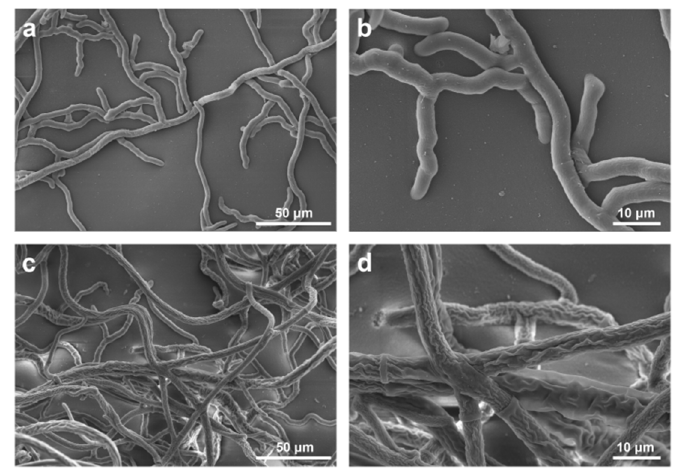
Figure 5. SEM of R. solani hyphae treated with 0 ( a , b ) or 1 μ g/mL 55 ( c , d ) .